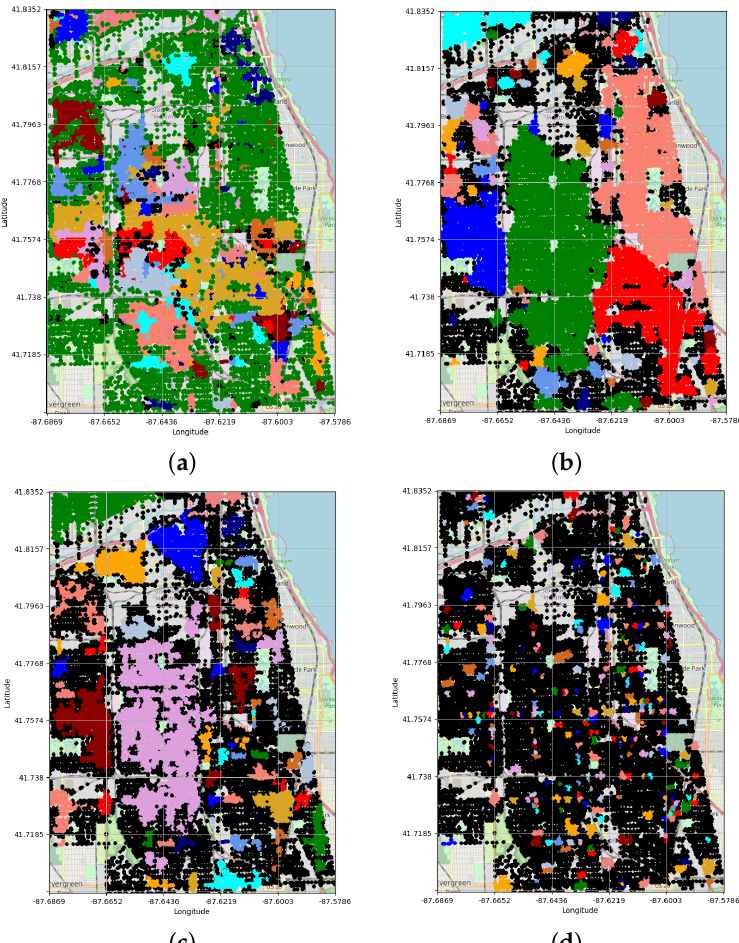
Figure 11. The Crime dataset: detected clusters. ( a ) CHD. ( b ) DBSCAN. ( c ) HDBSCAN. ( d )